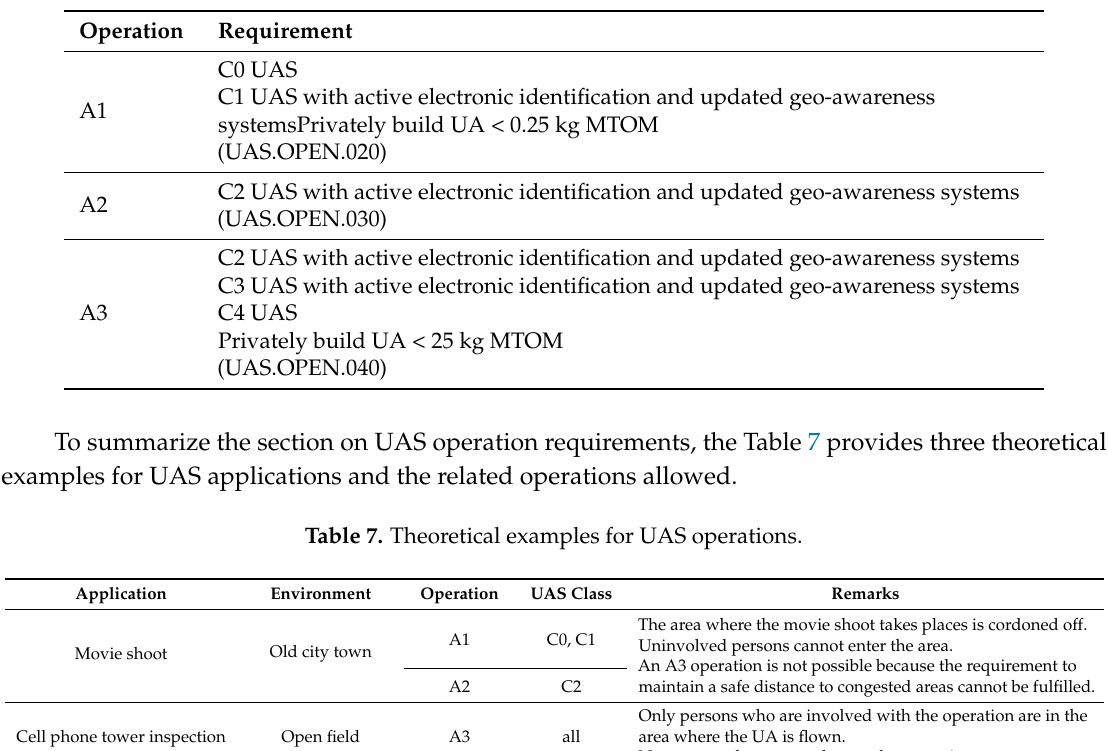
Table 6. Required UAS [8].